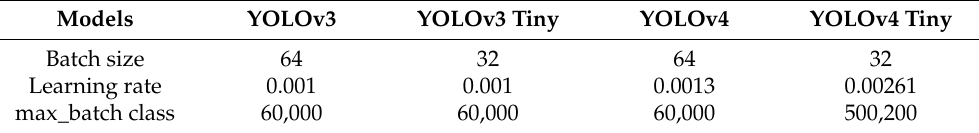
Table 3. Hyperparameters used for model simulation.